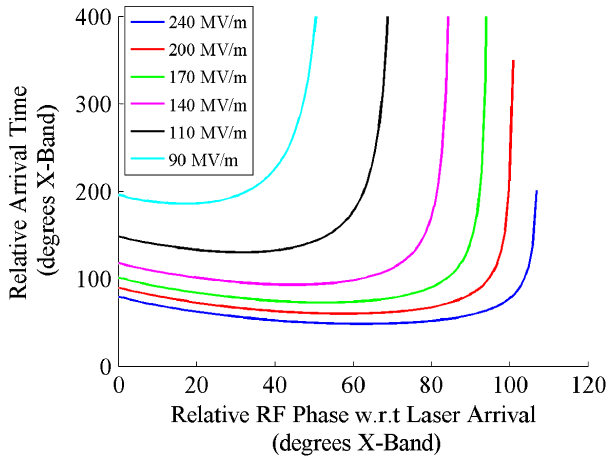
FIG. 15. Simulated RTOA versus rf phase relative to the laser arrival for different cathode